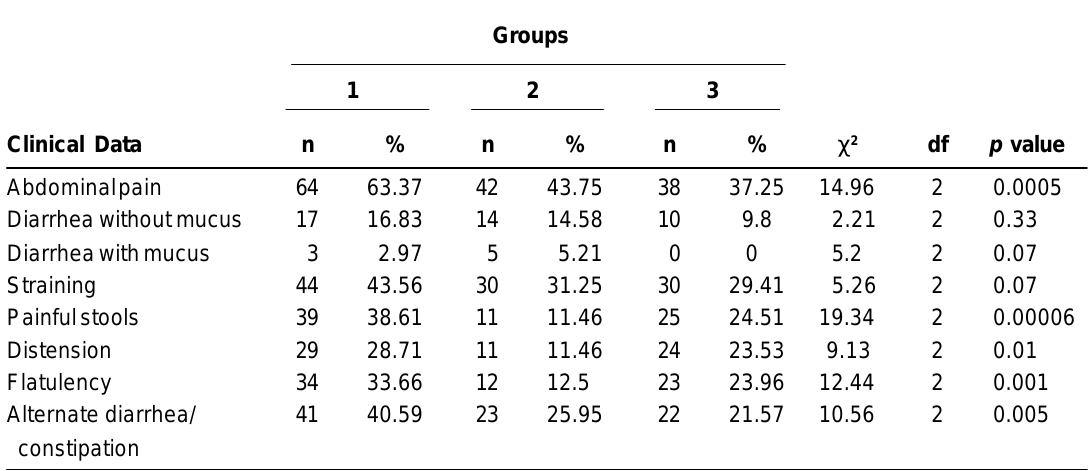
Clinical Data Reported to the End of